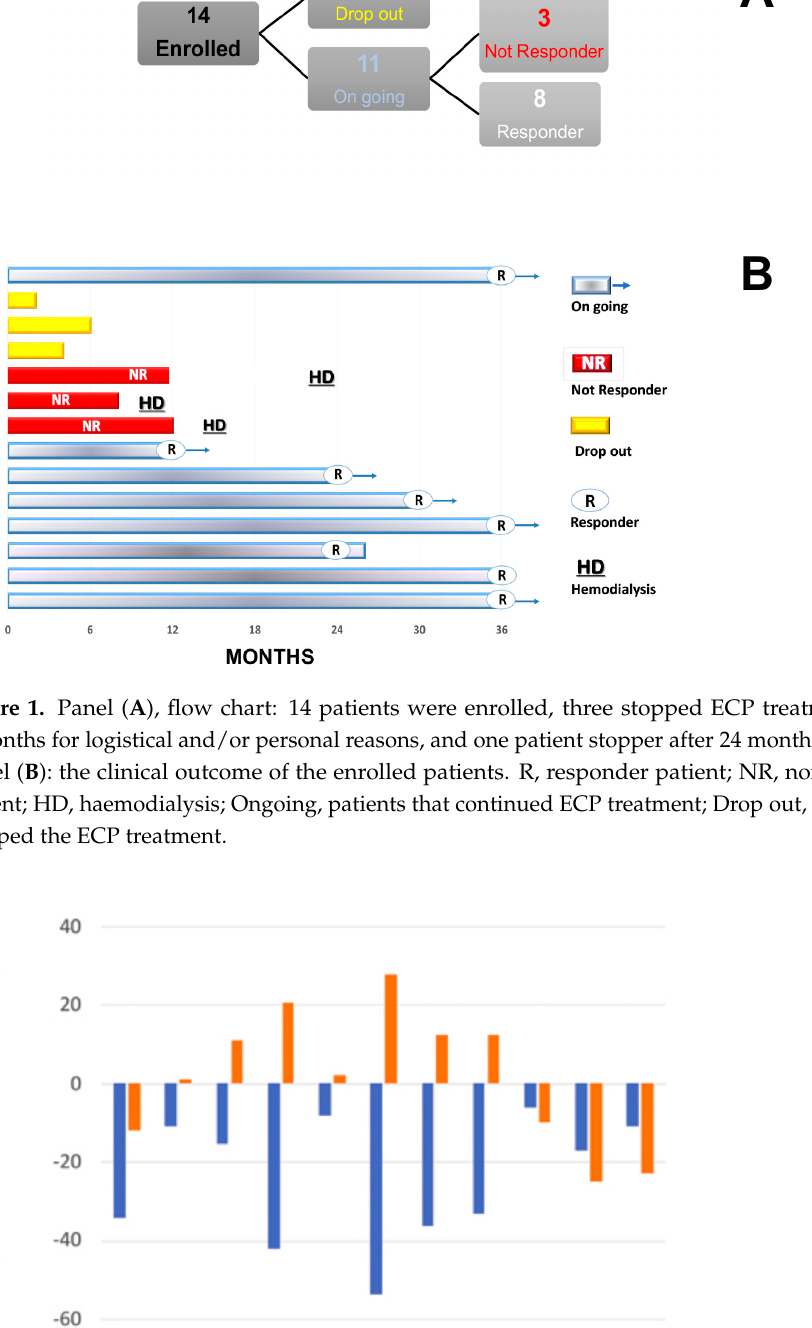
Figure 3. Renal function pre- and post-ECP treatment. Panel ( A ): The estimated glomerular filtration rate (eGFR was eval- uated 1 year before and after the ECP treatment in responder (R) patients (blue line) and the non-responder (NR) patients (red line). In the R patients, the ECP treatment was prolonged by up to 3 years, showing the stabilization of the eGFR at the last follow up. In the NR patients, the follow up was prolonged after the discontinuation of the ECP for up to 1 year in two patients (spaghetti plot). The red dashed line marks the follow up after the ECP’s stoppage in the NR group. The dashed gray line indicates the start of the ECP treatment. Panel ( B ): The eGFR trend over time in the R (blue line) and NR (red line) patients. The dashed gray line indicates the start of the ECP. The black cross marks the end of the ECP treatment in the NR group. The data are expressed as the mean and SD. Twenty four hour proteinuria did not increase in the R patients throughout the fol- low up, as opposed to the NR. It is noteworthy that the 24-h basal proteinuria of the NR